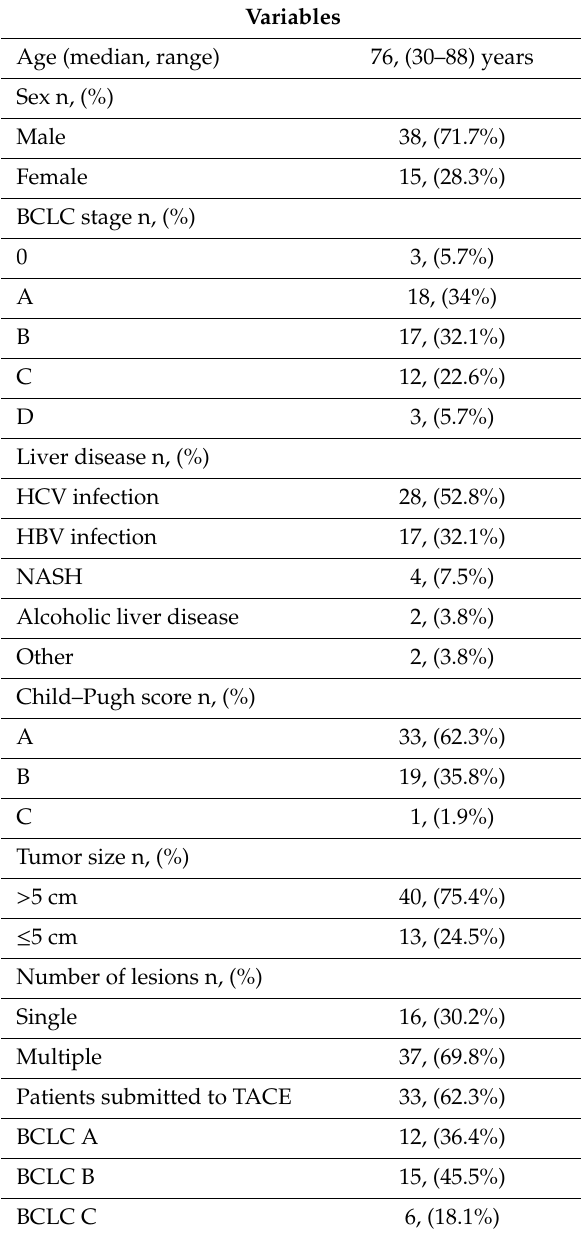
Table 1. Baseline patient